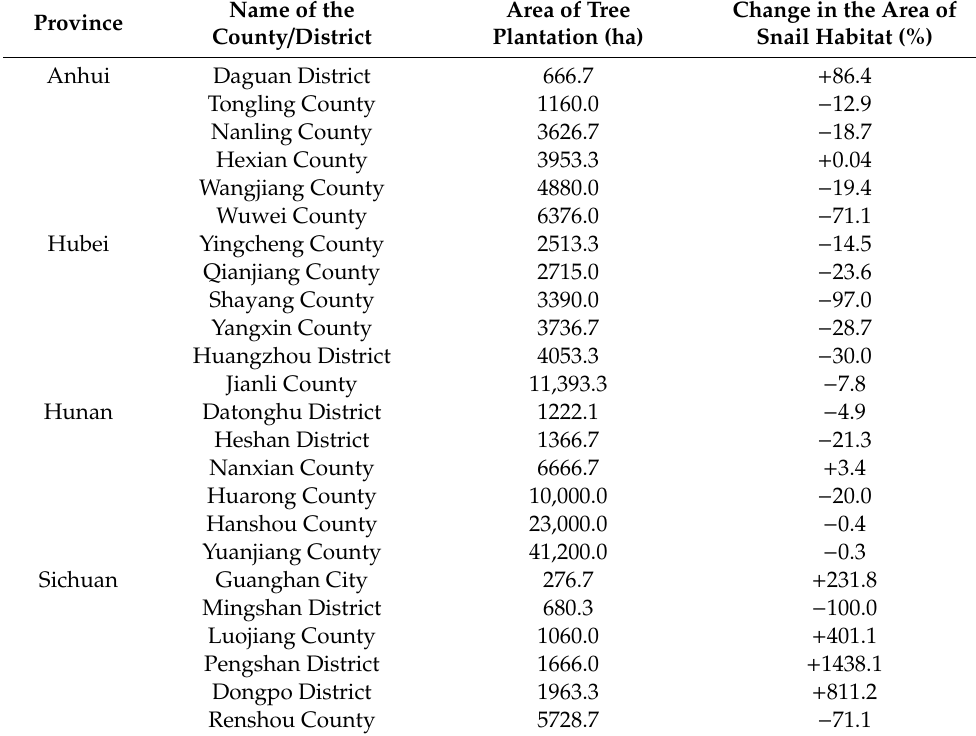
Table 3. Total planted areas and changes in acreages of snails’ habitats in 24 counties / districts between 2006 and 2015. The data for areas of tree plantations came from the State Forestry Administration of China while the data for changes in snail habitats came from the Center for Disease Prevention and Control of China (China